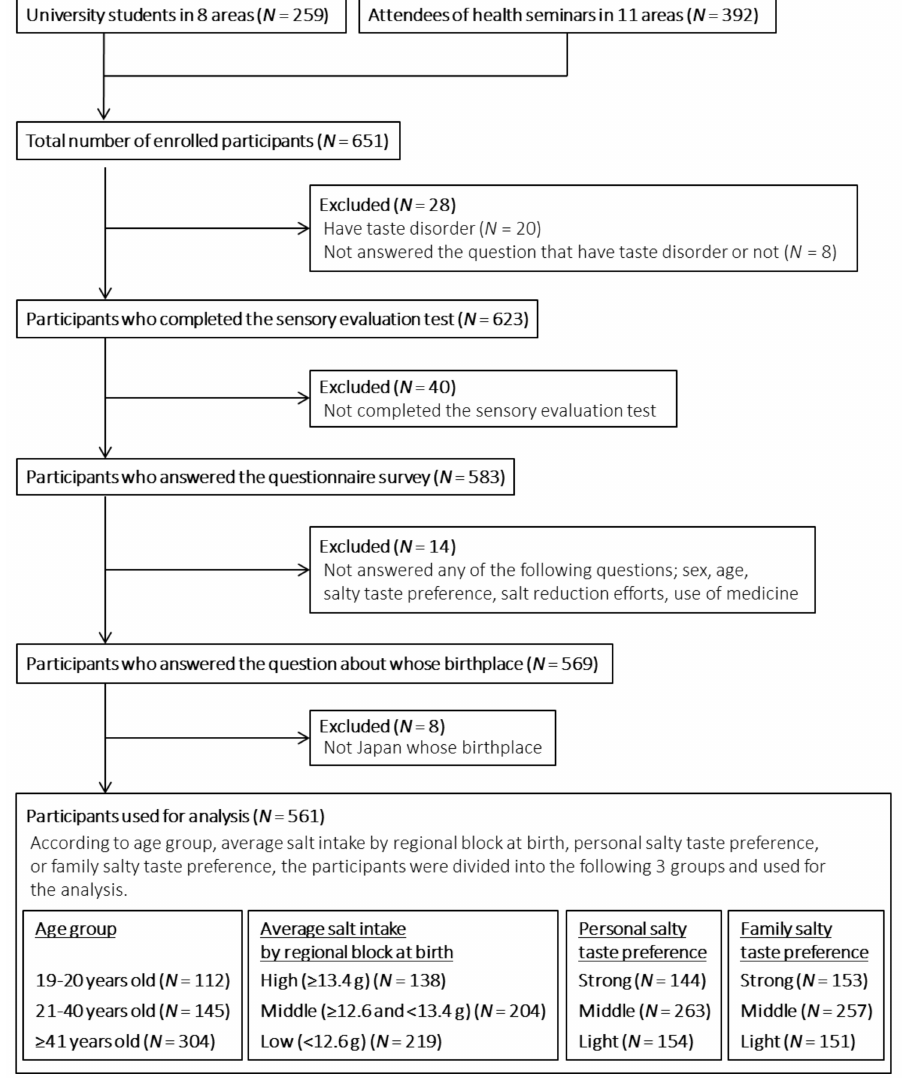
Figure 1. Flow chart on the analyzed